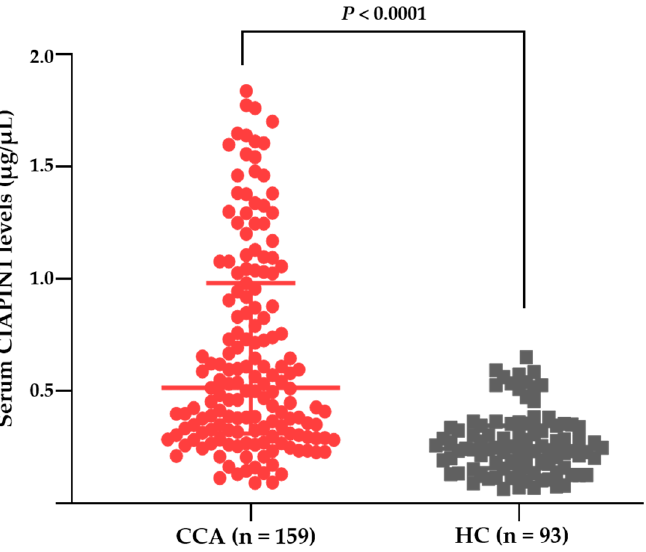
Figure 4. The serum CIAPIN1 levels of CCA and HC groups using a dot blot assay. The median level ± quartile deviation of CIAPIN1 was 0.5144 ± 0.34 µg/µL in the CCA group and 0.2427 ± 0.09 µg/µL in the HC group.